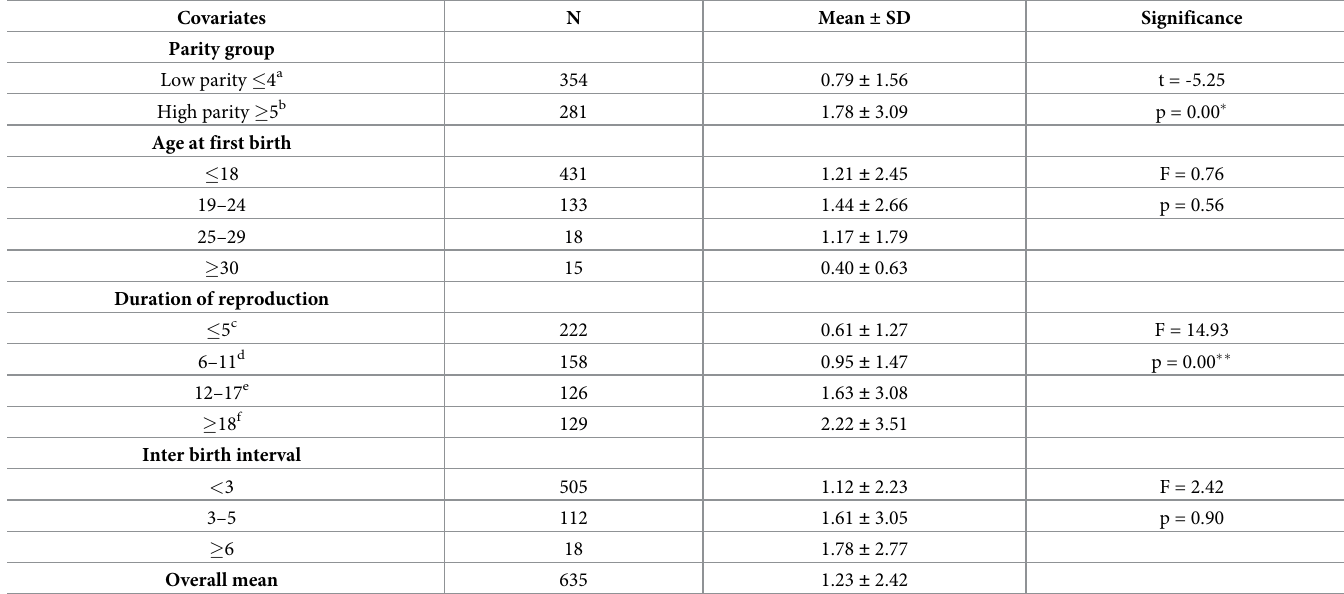
Table 2. Mean DMFT scores by reproductive parameters.